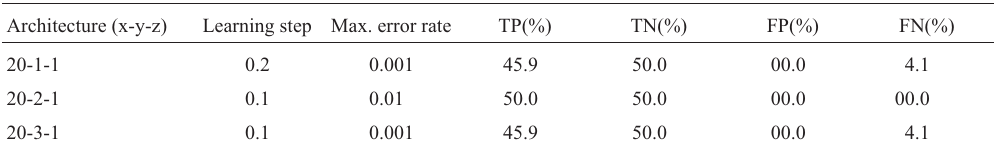
Table3 -Comparisonbetweenthesecondmodelnetworks.ThecolumnArchitecture(x-y-z)indicatesthenumberofunitsintheinput,hidden,andoutput layers, respectively. Architecture